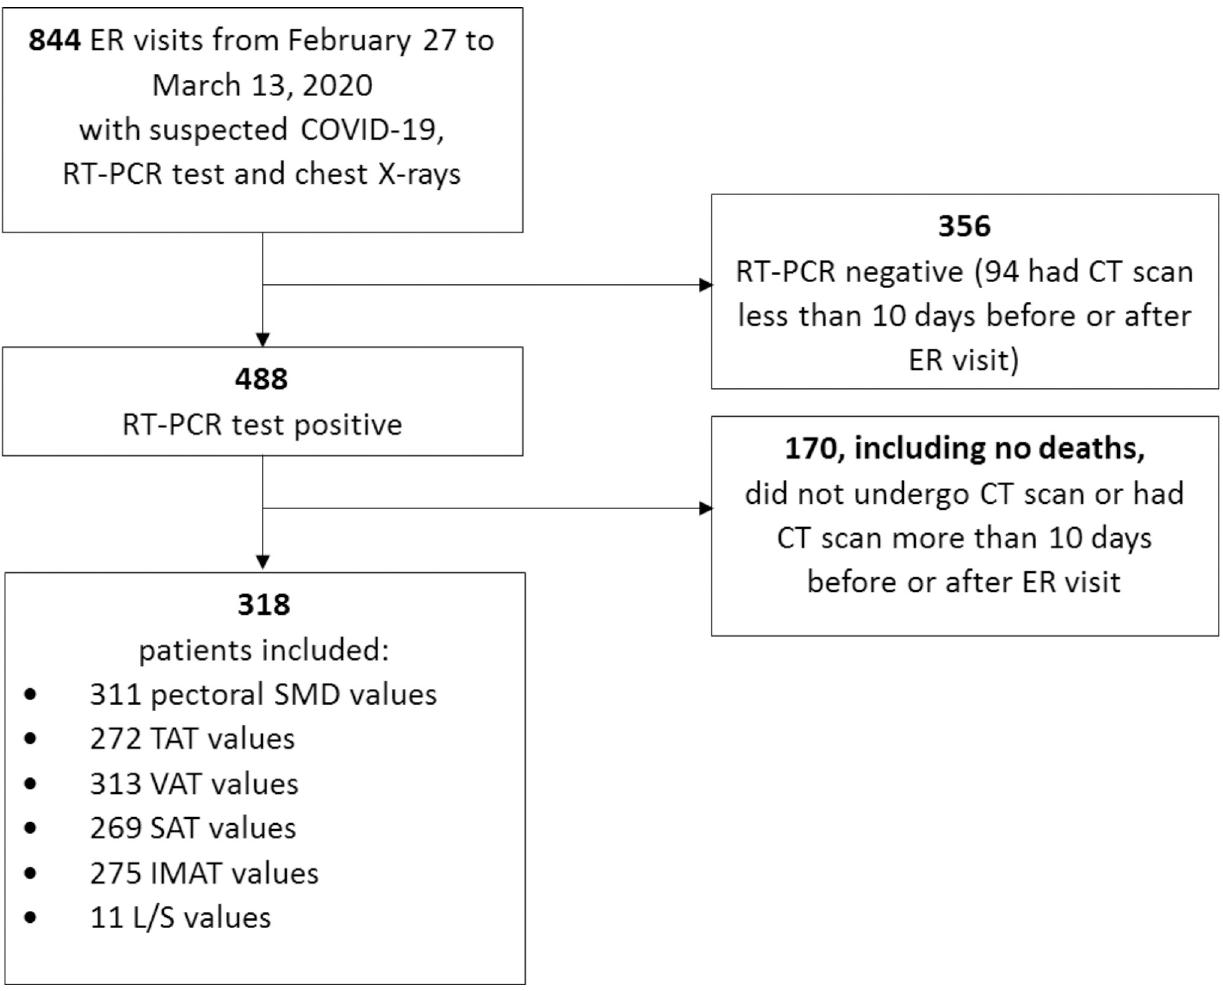
Fig 1. Flowchart describing patient selection. https://doi.org/10.1371/journal.pone.0251768.g001 hospitalization and MV or death. For death alone, pectoral muscle density and VAT were line- arly associated and almost no association was observed for TAT, while the relationship with IMAT was better described by a model including IMAT quartiles. As no association was found with the three outcomes, pectoral muscle area and liver-to-spleen ratio were dropped in subse- quent analyses. Intrareader agreement. Intrareader agreement was excellent for pectoral muscle area and density and for fat compartment areas (Spearman rho between 0.96 and 1.00, p < 0.001) and moderate for liver-to-spleen ratio (Spearman rho = 0.78, p = 0.001). Associations between body composition parameters and patient outcomes After correcting for age, sex and calendar period, increased muscle density showed a protective effect on hospitalization (OR for one HU increase = 0.967; 95%CI = 0.935–1.000), death (OR for one HU increase = 0.962; 95%CI = 0.922–1.004) and MV or death (OR for one HU increase = 0.964; 95%CI = 0.934–0.996) (Fig 2). Increased TAT was a risk factor for hospitali- zation and for MV or death (OR for one cm 2 increase = 1.005; 95%CI = 1.002–1.008 and OR